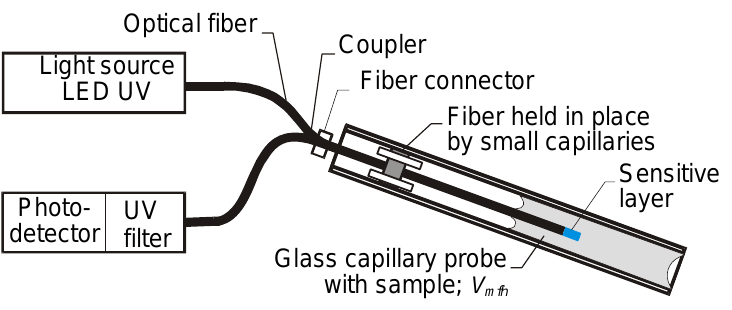
Figure 10. Optical fiber sensor using a capillary probe.